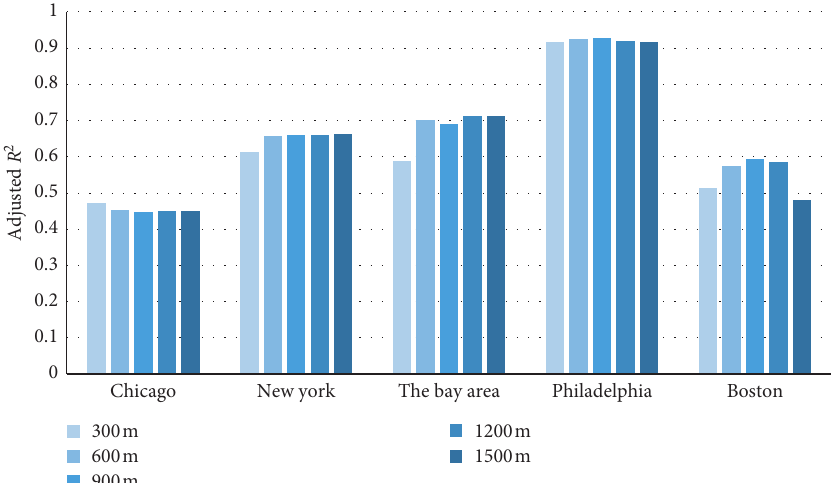
Figure 7: Linear regression result of five different catchment areas.